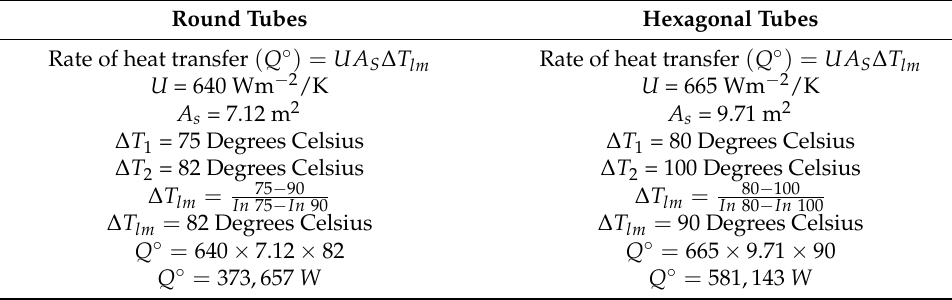
Figure 11. Heat transfer convergence plot. Table 5. Computation of the experimental heat transfer rates at fluid